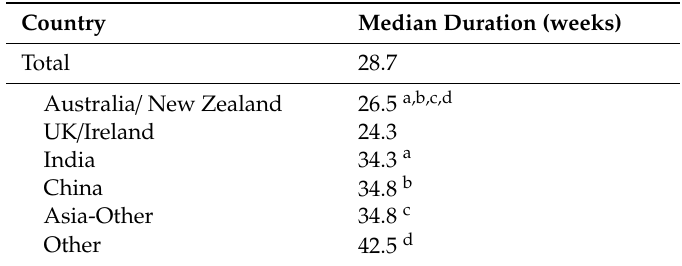
Table 3. Median duration of breastfeeding by mother’s country of